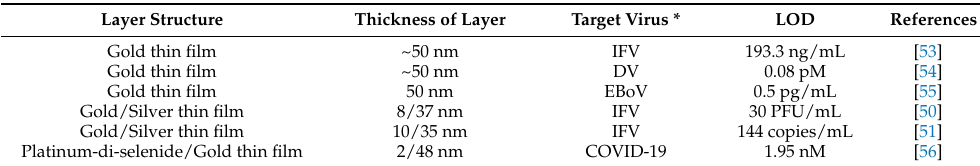
Table 1. Comparison layer material and thickness related with limit of detection (LOD) for virus sensing using